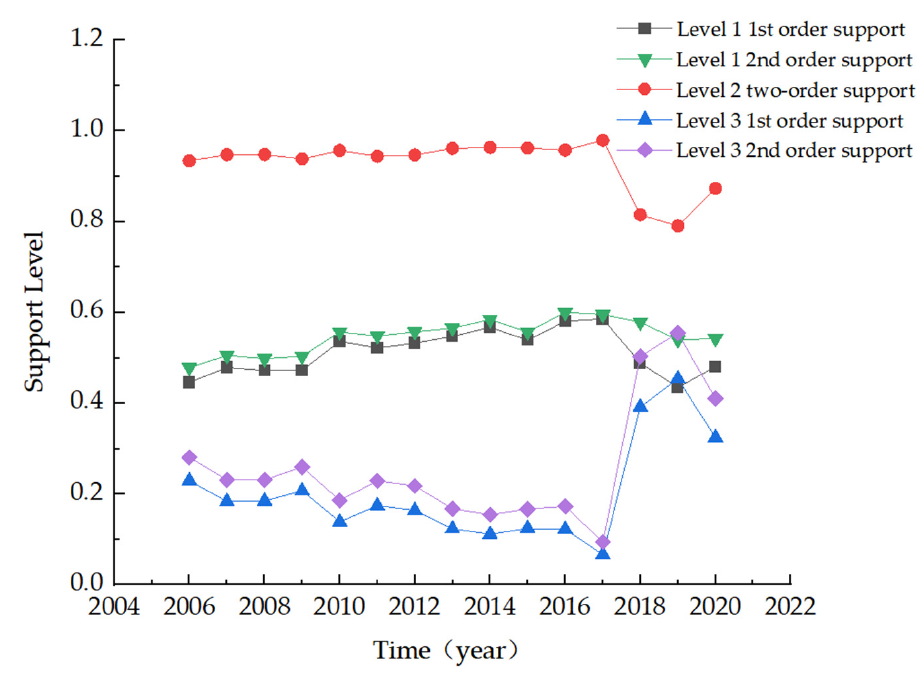
Figure 3. Grade support evolution curve.